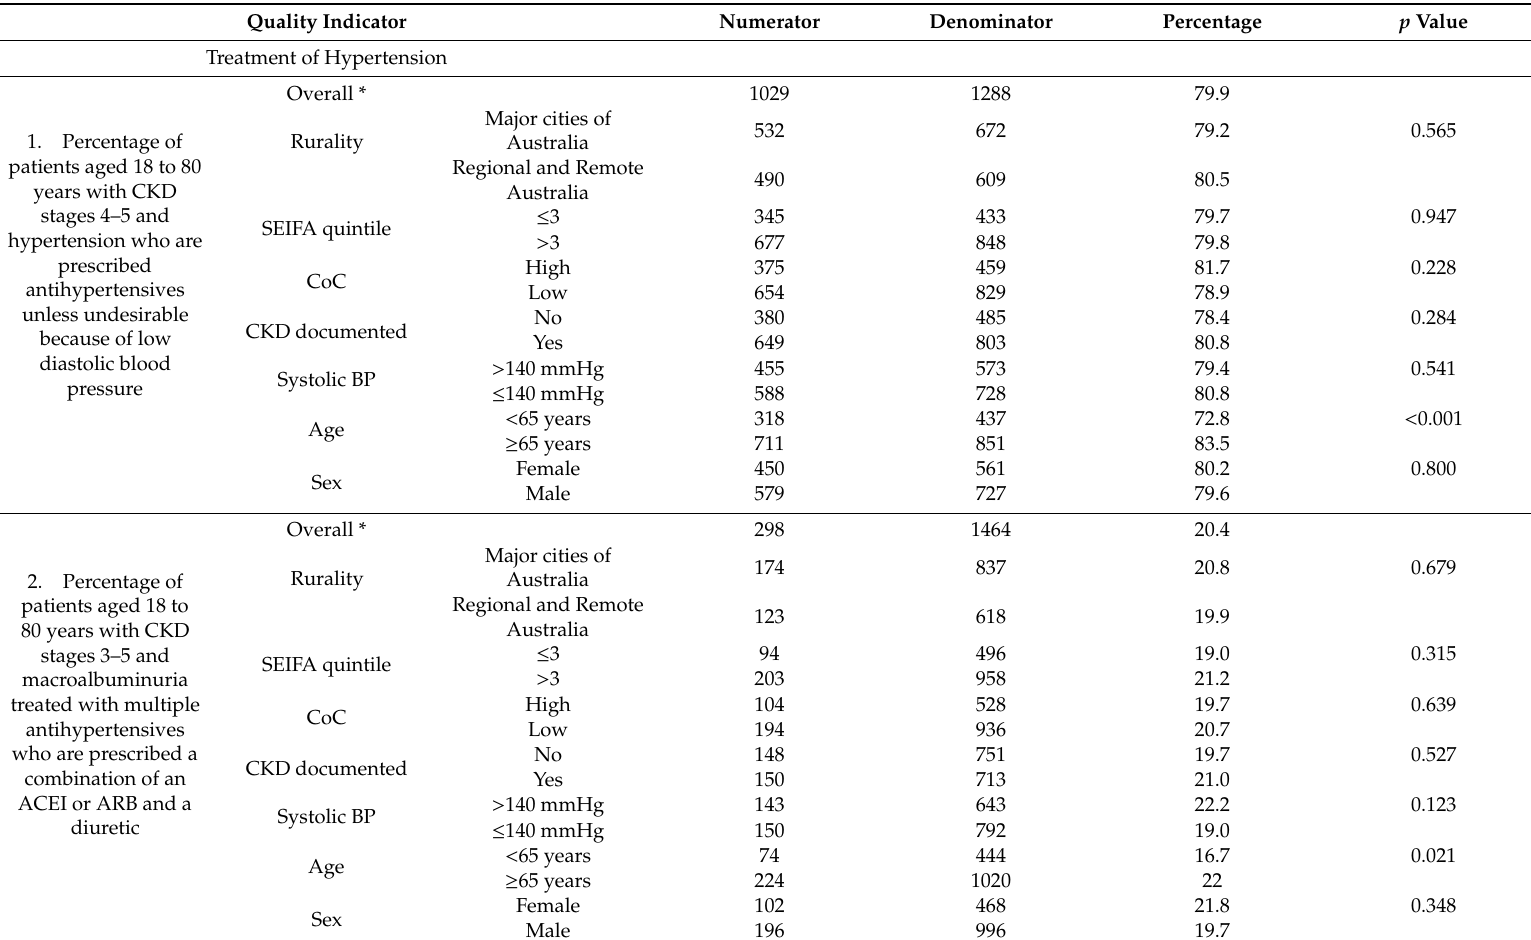
Table 4. Number and proportion of patients meeting prescribing quality indicators by rurality, socio-economic indexes for areas (SEIFA) and CKD documentation [4]. Quality